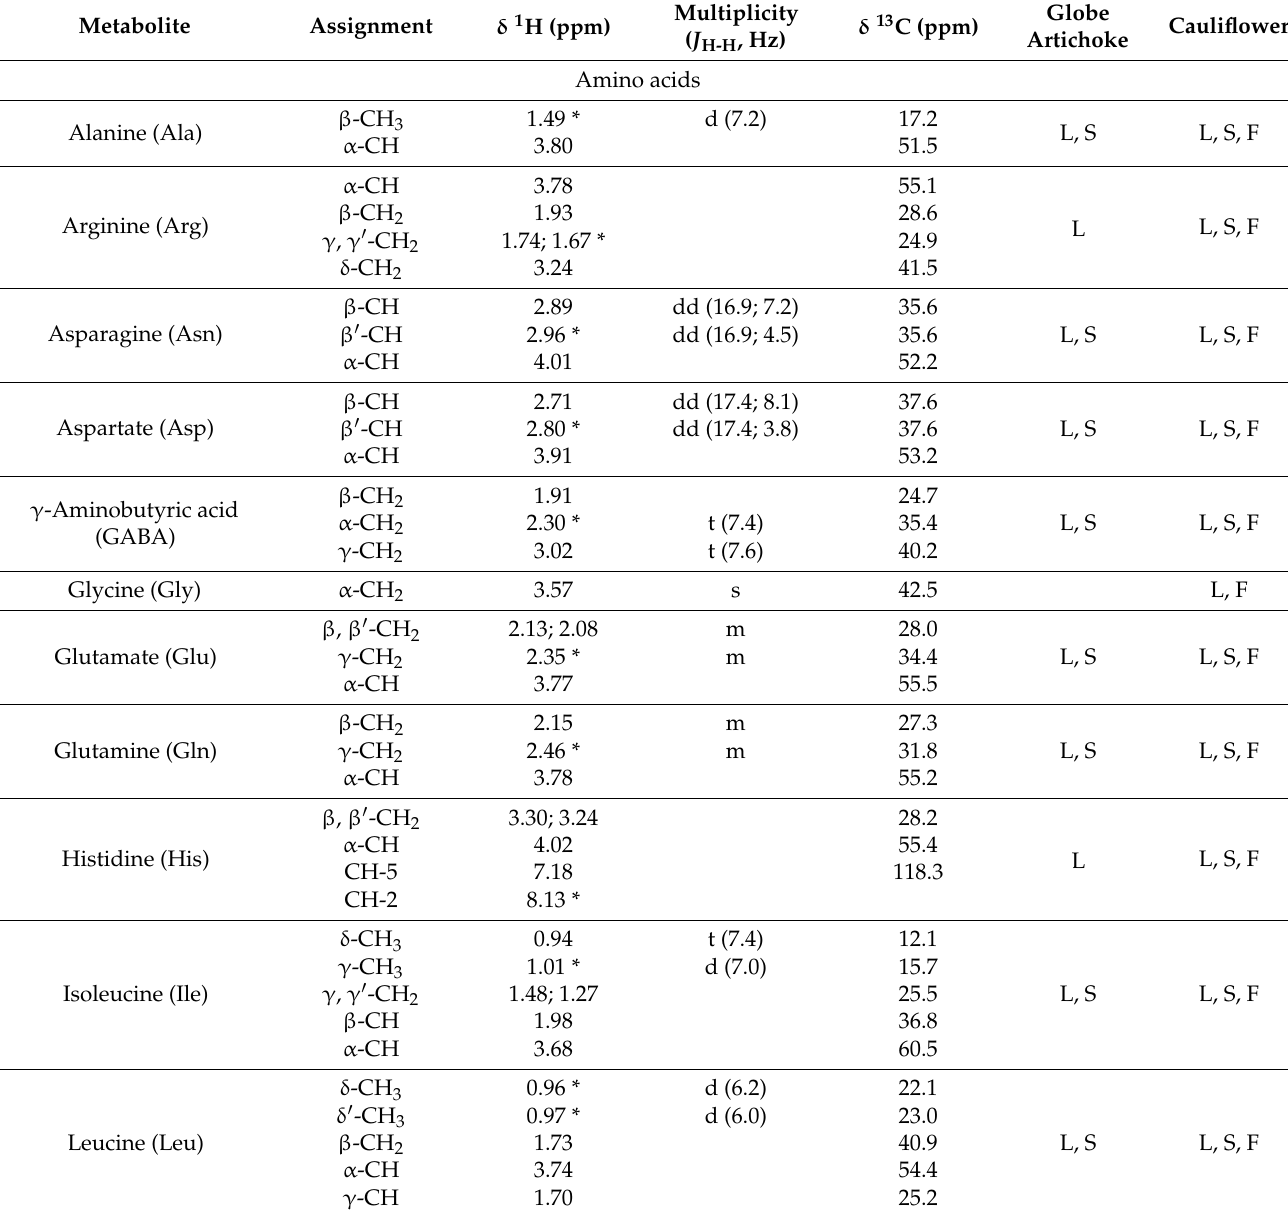
Table 1. Metabolites identified in aqueous extracts of cauliflower and globe artichoke